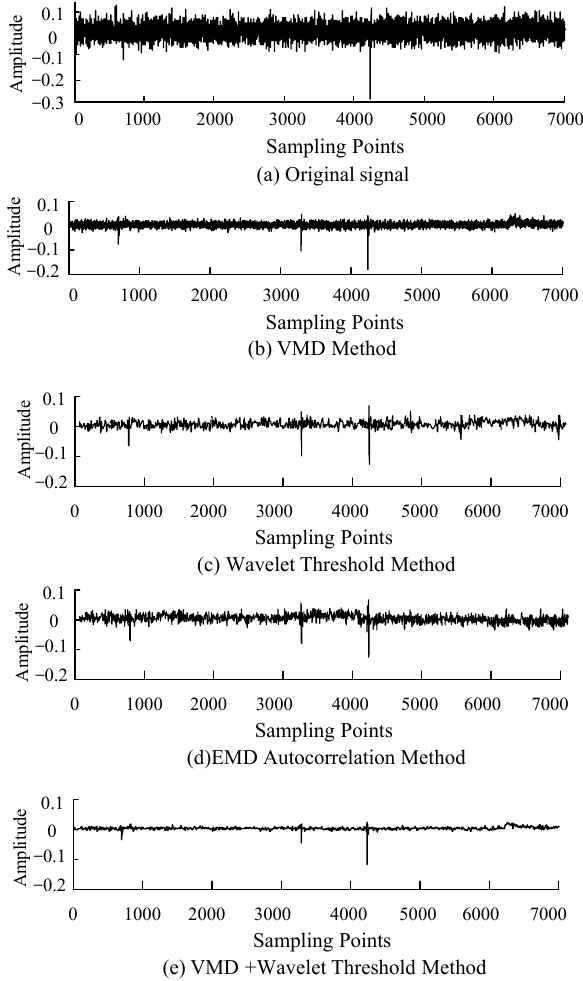
Figure 8. Analysis of PD signal obtained in laboratory.